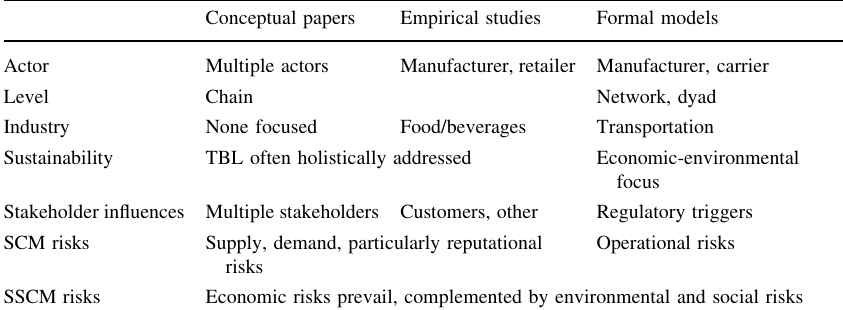
Table 15 Most common foci regarding all structural dimensions of the content analysis for conceptual, empirical, and formal modeling